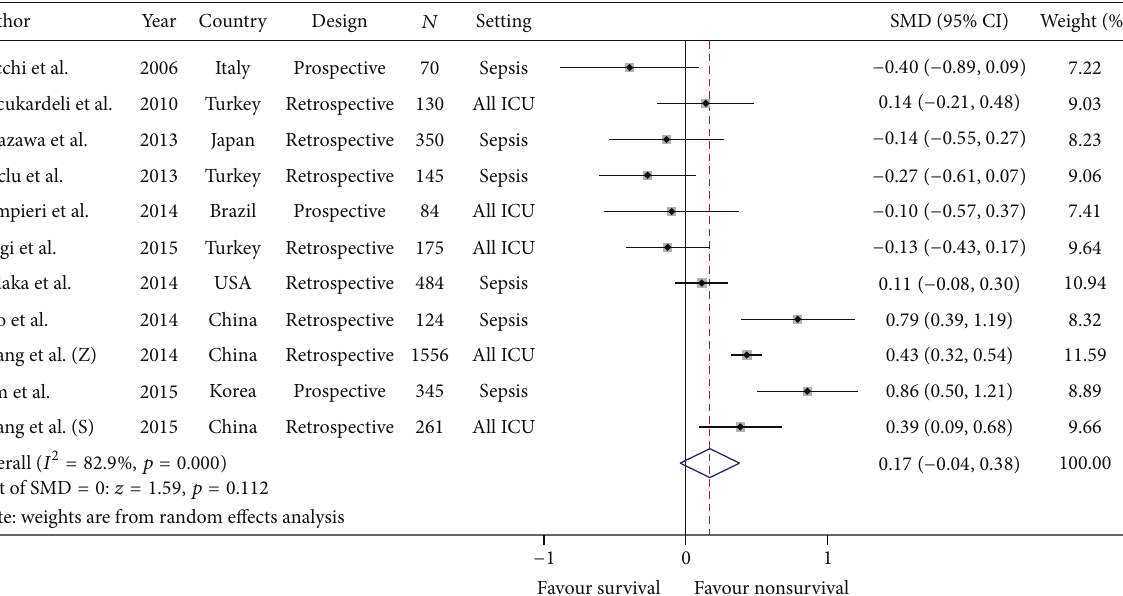
Figure 2: The pooled mean differences of the mean platelet volume between critically ill nonsurvivors and